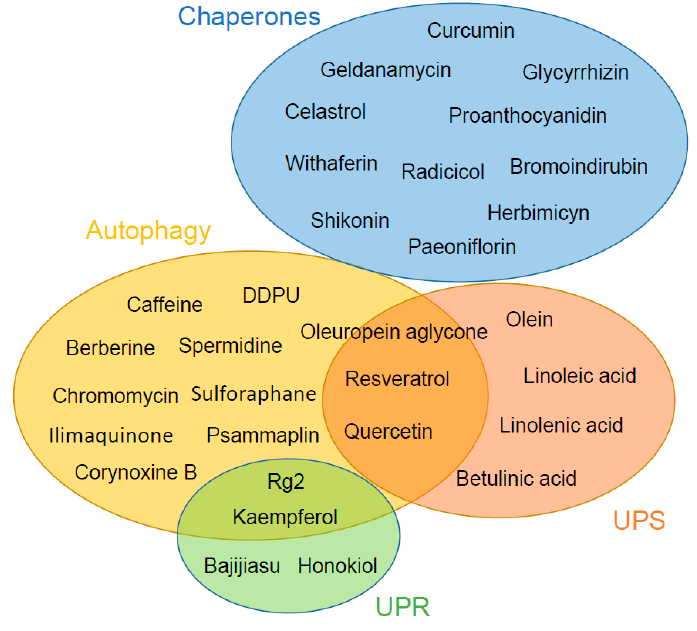
Figure 1. Schematic representation of natural compounds that positively regulate different elements of the proteostasis machinery. There is an extensive heterogeneity of chemical classes that compose the proteostasis-enhancing compounds, however we observed an enrichment in polyphenolic molecules. It is noted that oleuropein aglycone, resveratrol, and quercetin target the autophagy and the UPS, suggesting that they could be used as strong activators to restore the proteostasis network during aging and disease, whereas chaperones’ modifiers seem to exclusively interfere with this pathway.